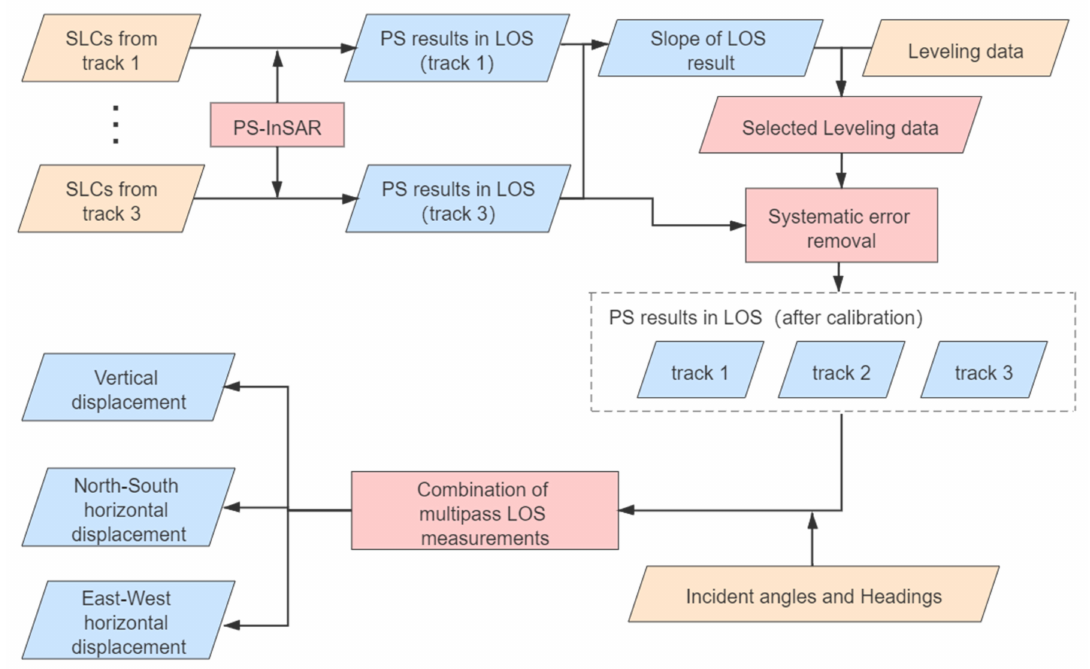
Figure 3. Framework of the 3-D surface displacement estimation method. (LOS: Line of